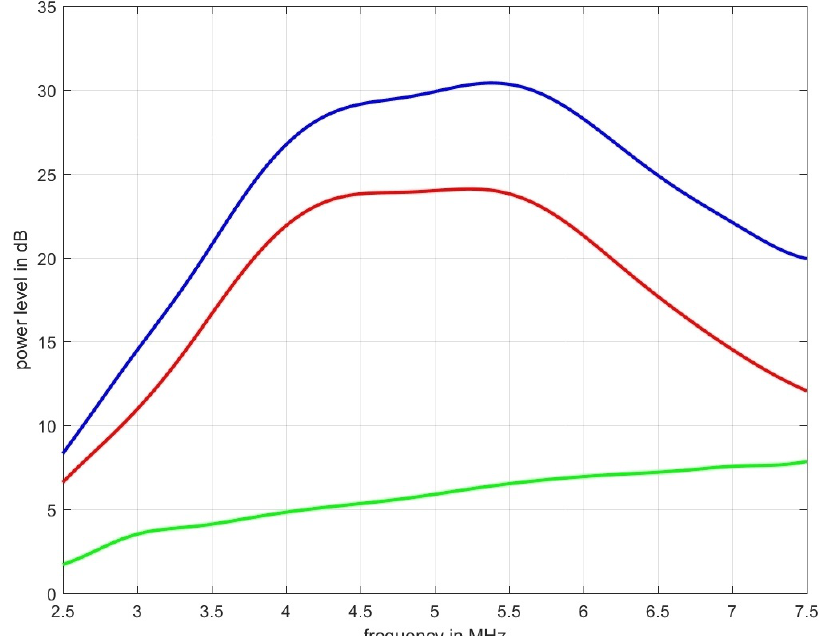
Figure 6. The blue graph represents the power spectral density for the ultrasound propagation in pure water, the red line is the measured spectrum obtained over the thickness of 2 cm of the tissue mimicking phantom depicted in Figure 1 which was designed to result in an α 0 of 0.6 dB/(MHz cm), and the green line is the spectral-log-difference. The two estimators used, led to an estimated attenuation of: (cid:98) α 0 | SLD = 0.5663 dB/(MHz cm) and (cid:98) α 0 | MoM = 0.5759 dB/(MHz